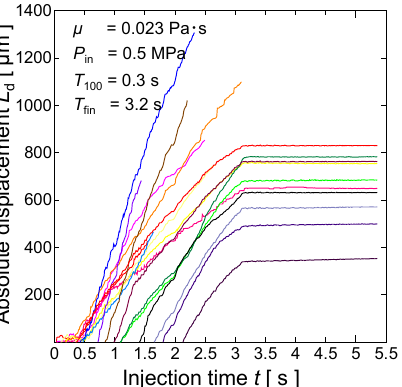
Figure 18. Time evolution of L d with injection pressure of P in = 0.5 Pa.